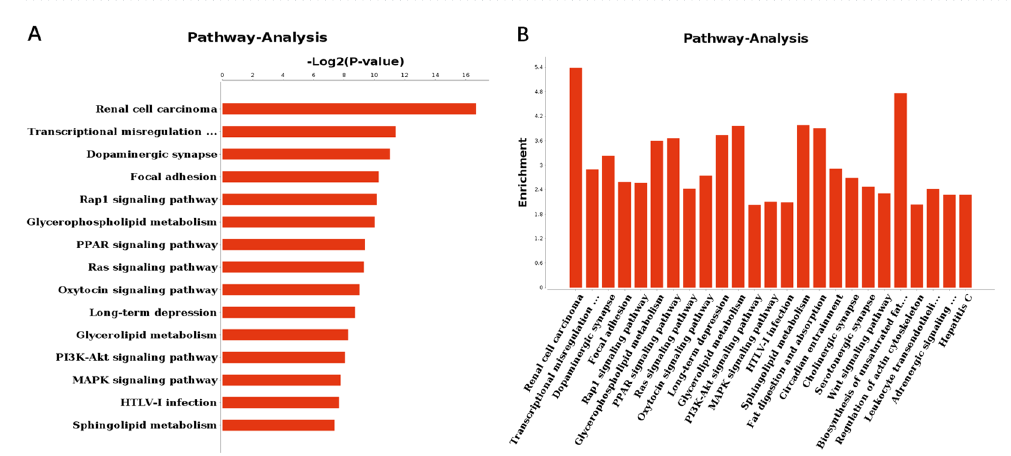
Figure 6. GO analysis for targeted genes of differentially expressed miRNA. − Log2 (p value) of the corresponding biological process(BP), molecular function(MF) and cellular component(CC) (the top 15 GO annotations of each section). Log2 (P-value) is the negative logarithm of P-value; bigger Log2 (P-value) indicates smaller P-value.